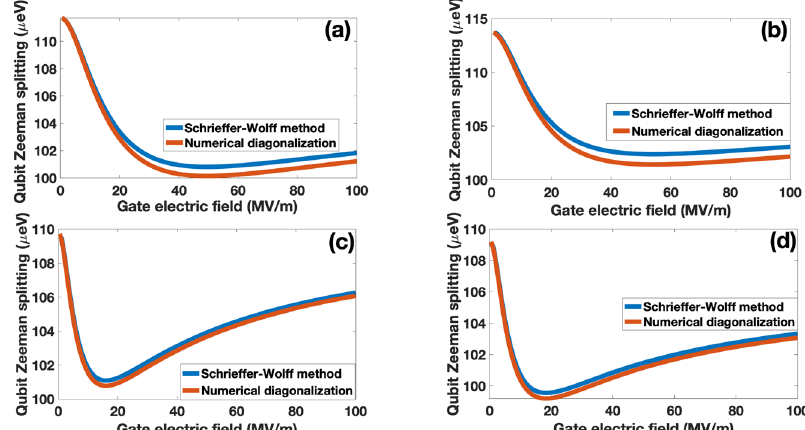
Fig. 2 The qubit Zeeman splitting. Comparison of the qubit Zeeman splitting between Schrieffer-Wolff transformation (to the third order) and exact numerical diagonalization for four different con fi gurations. When the gate electric fi eld is turned off, the qubit Zeeman splitting g 0 μ B B ≈ 110 μ eV. In all these fi gures, the out-of-plane magnetic fi eld is B = 0.1 T. We can notice that the sweet spot does not change much as a function of the quantum dot radius, but the size of the qubit Zeeman splitting will be smaller for a larger quantum dot size. In all of these plots, we have (cid:2) h ω l ≫ g 0 μ B B . Numerical diagonalization is the red curve, Schrieffer-Wolff method is the blue curve. a d = 11 nm, a 0 = 50 nm. b d = 11 nm, a 0 = 60 nm. c d = 15 nm, a 0 = 50 nm. d d = 15 nm, a 0 = 60